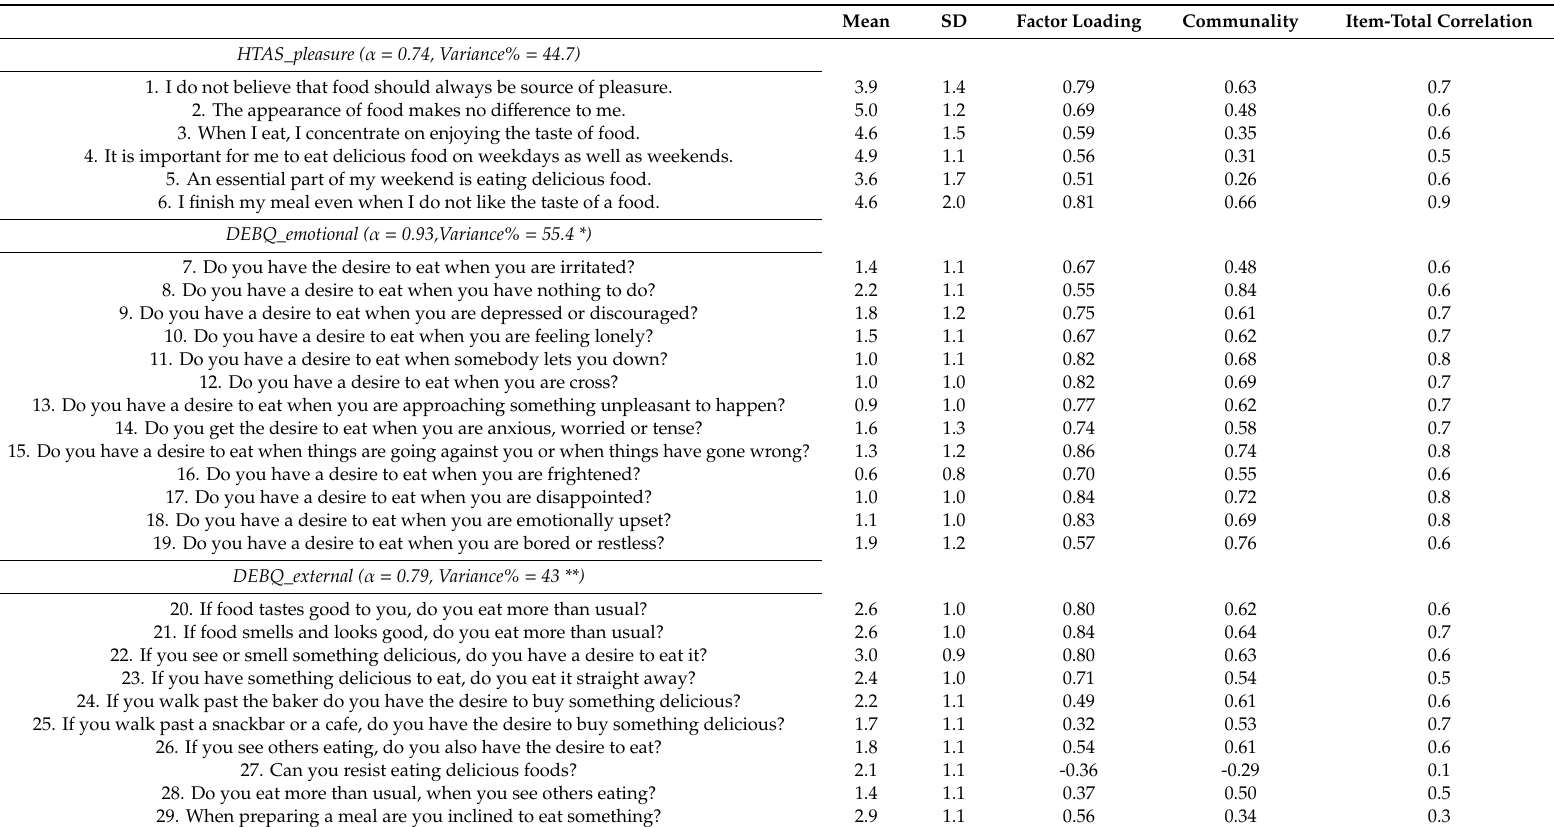
Table A1. Means, standard deviations (SD), and reliabilities for used